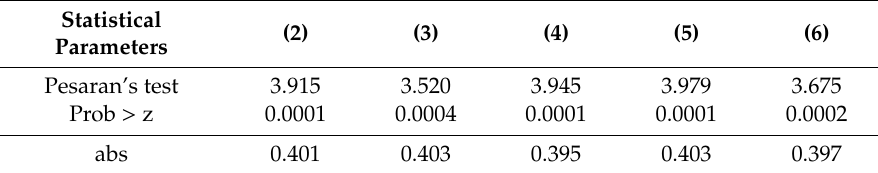
Table A6. Pesaran test inspection dependence between units.